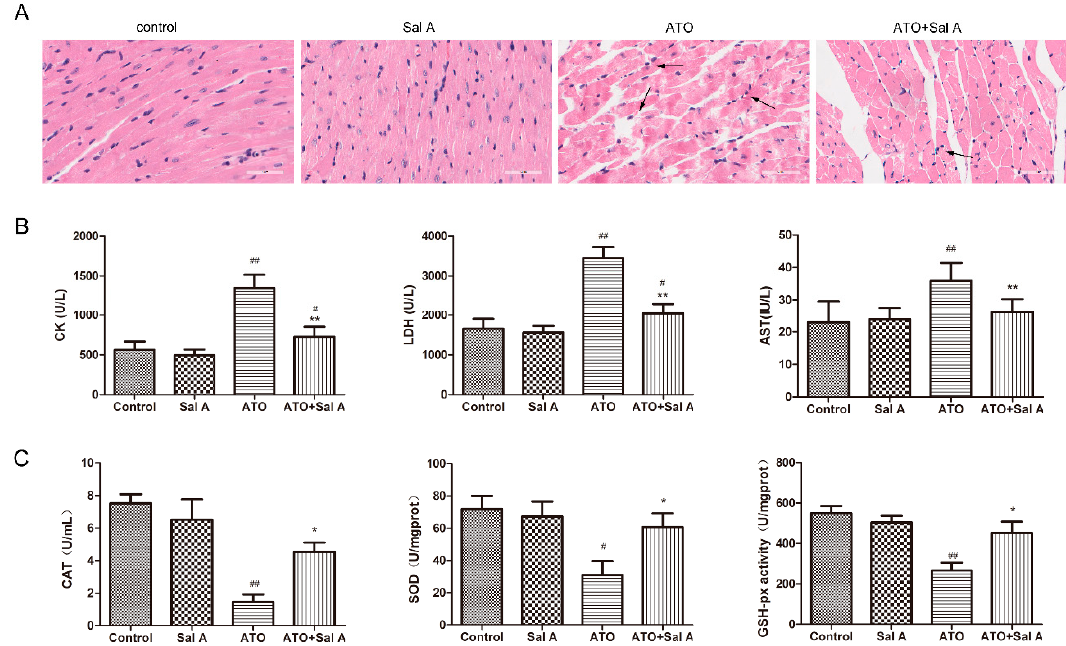
Figure 3. Sal A alleviated ATO-induced myocardial injury in mice hearts. ( A ) Hematoxylin-eosin (HE) staining showed the effects of Sal A on histological changes of mouse hearts. The scale bar is 50 μ m. ( B ) Effects of Sal A on creatine kinase (CK), lactate dehydrogenase (LDH), and aspartate aminotransferase (AST) activity in plasma, and ( C ) effects of Sal A on catalase (CAT), superoxide dismutase (SOD), and glutathione peroxidase (GSH-PX) activity in plasma, expressed as the mean ± SD ( n = 15 per group). # p < 0.05 vs. control; ## p < 0.01 vs. control; * p < 0.05 vs. ATO group; ** p < 0.01 vs. ATO group.